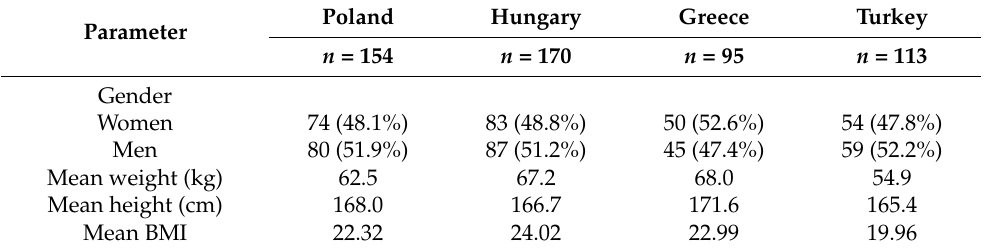
Table 1. Characteristics of the studied population.